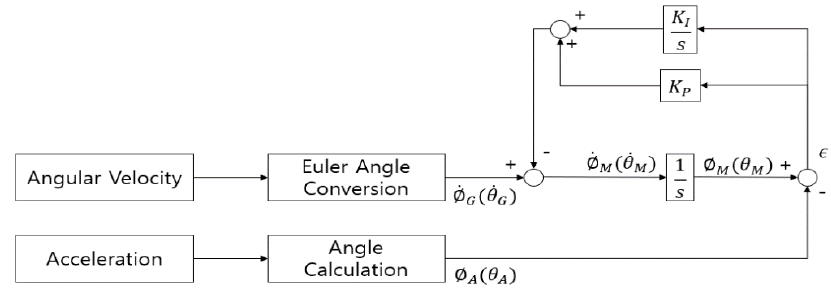
Figure 5. Vertical angle (VA) calculation using a complementary filter with a PI controller.